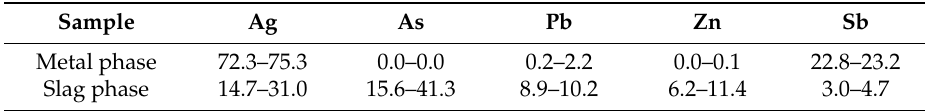
Table 5. Composition ranges (wt. %) of metal and slag phases generated in several oxidizing melting experiments of silver ore.